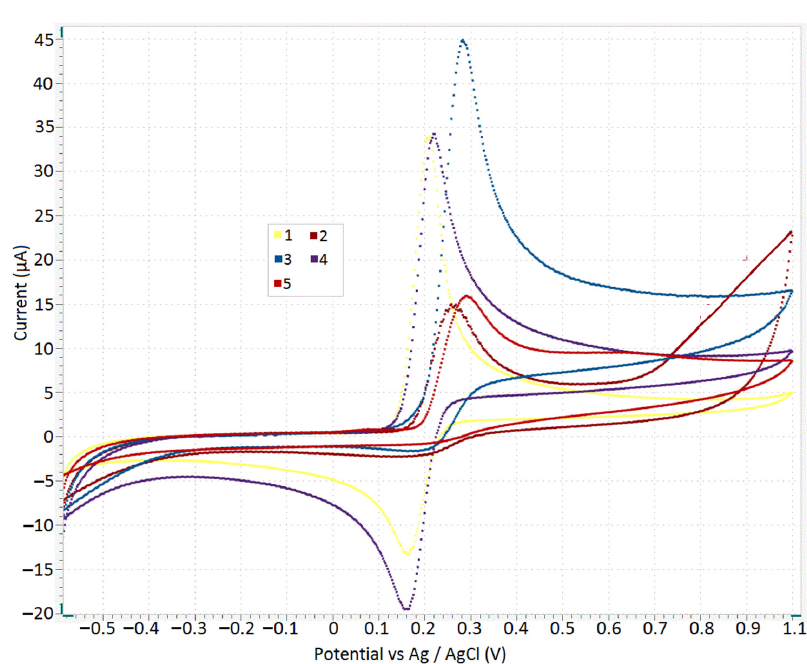
Figure 1. Cyclic voltammograms of 7,8-dihydroxy-4-methyl-chroman-3-toluene-2-one (1), Luteolin (2), 4-Methylesculetin (3), 4-Methyldaphnetin (4), and Nordalberginluteolin (5) recorded on a glassy carbon electrode, reference electrode—silver chloride electrode, C(AO) = 0.1 mM. Background: phosphate buffer solution–ethanol 1:1. Scan rate is 0.05